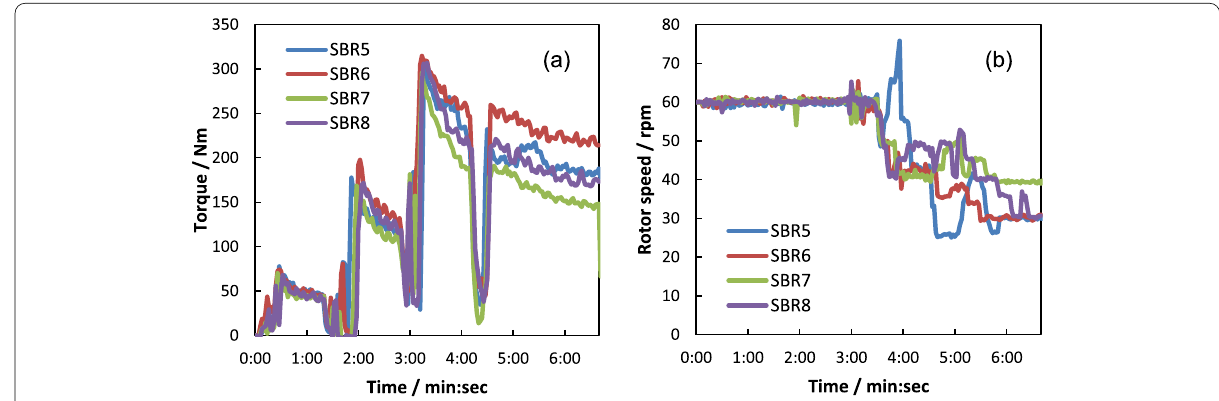
Fig. 9 Mixing behavior of the compounds with branched SBRs; a mixing torque, b rotor